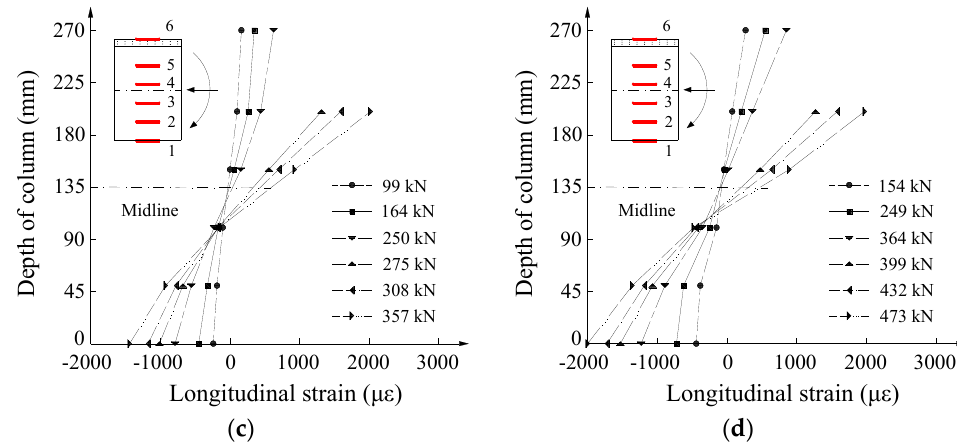
Figure 12. Strain at different depths of the mid-span cross section: ( a ) S-0, ( b ) S-1, ( c ) S-2, ( d ) S-3. Strain gauge No. 6 failed at the highest loading levels in each figure.